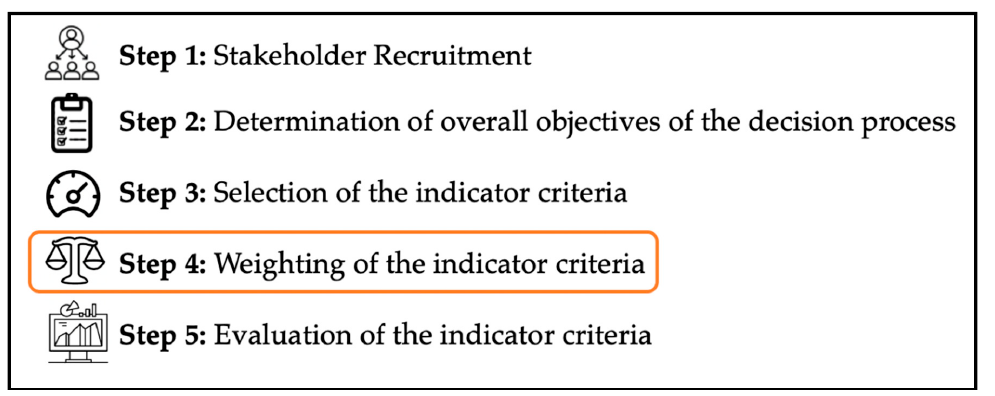
Figure 1. The steps of the deliberative process. This paper pertains to “Step 4: Weighting of the indicator criteria” which refers to conducting the stakeholder engagement